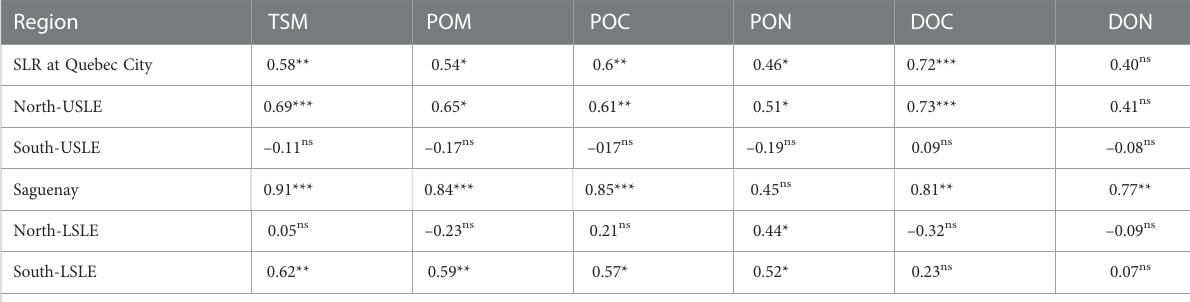
TABLE 2 Pearson correlations between TSM and OM concentrations and discharge of tributaries of each region. Region TSM POM POC DOC DON